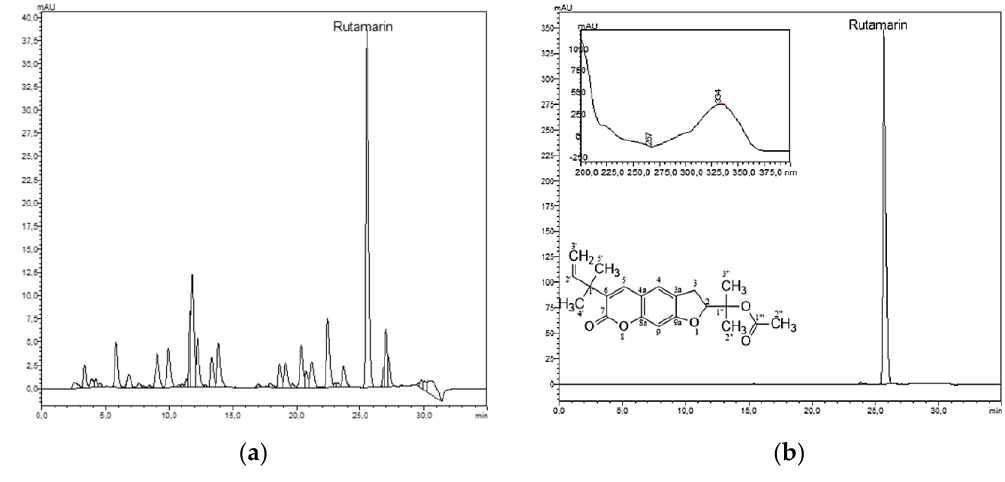
Figure 1. HPLC–DAD chromatograms of ( a ) crude dichloromethane extract of Ruta graveolens L. and ( b ) isolated rutamarin ( λ = 335